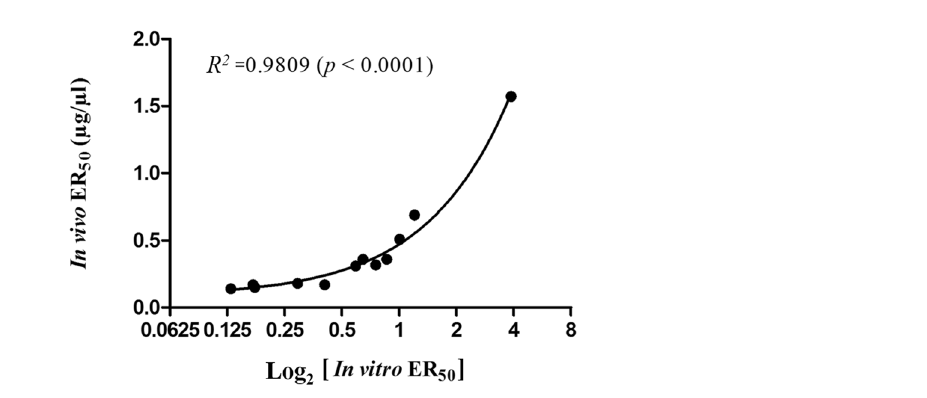
In vitro ER 50 ± S.D. ( µ g venom/ µ l antiserum) Horse Nk-A